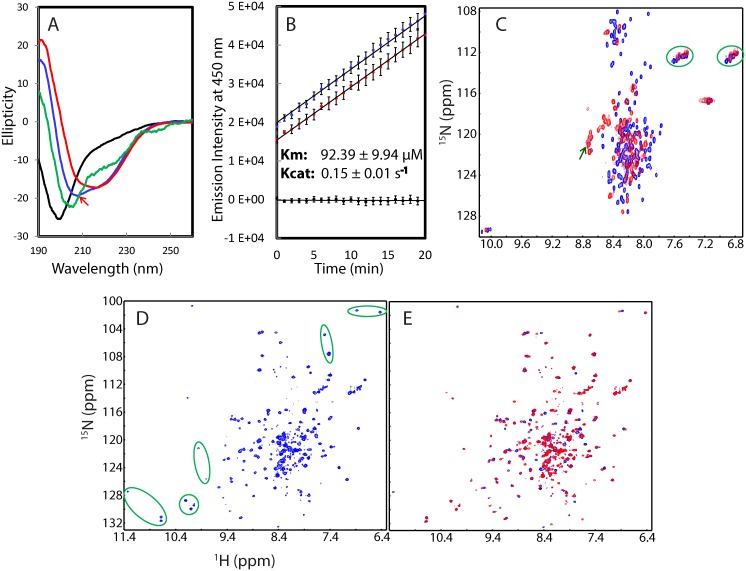
Conformations and activity of the refolded NS3pro in complex with NS2B(40–100).(A) Far-UV CD spectra of the isolated NS3pro (black), NS2B (48–100) (green), refolded NS2B (48–100)-NS3pro complex at a molar ratio of 1:1 at Milli-Q water at pH 4.0 (blue) and in the buffer at pH 7.5 (red). (B) Enzymatic activities of the isolated NS3pro (black), NS2B-NS3pro complex refolded at pH 4.0 (blue) and at 7.5 (red) as measured in the assay buffer (pH 7.5) by monitoring the increase of the emission fluorescence intensity at a wavelength of 450 nm. The Km and kcat values are presented for the complex refolded at pH 7.5. (C) HSQC spectra of the isolated NS3pro (blue) and NS2B-NS3pro mixture (red) in Milli-Q water (pH 4.0). (D) HSQC spectrum of the refolded NS2B-NS3pro complex in which only the NS3pro is 15N-labeled in buffer (pH 7.5). Green ovals are used to indicate characteristic peaks also observed in the previous reports (refs. 10 and 11). (E) HSQC spectra of the NS2B-NS3pro in buffer (pH 7.5) in the absence (blue) and in the presence of the protease inhibitor p-Nitrophenyl-p-guanidino benzoate (red).